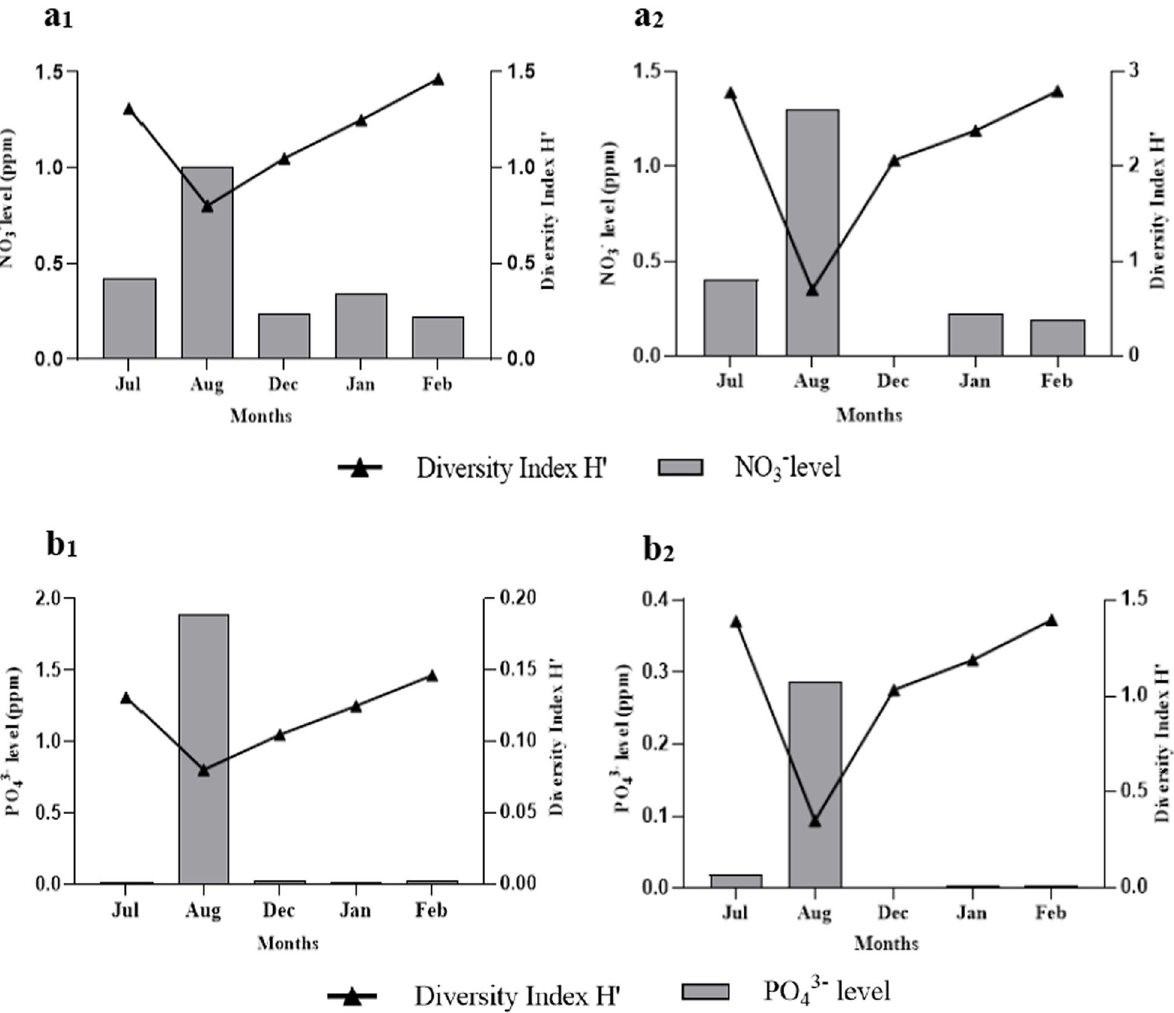
Fig. 2 Zooplankton diversity fluctuation in Vavuniya reservoir (left) and Thandikulam reservoir (right) during July 2018–February 2019. a 1 and a 2 NO −